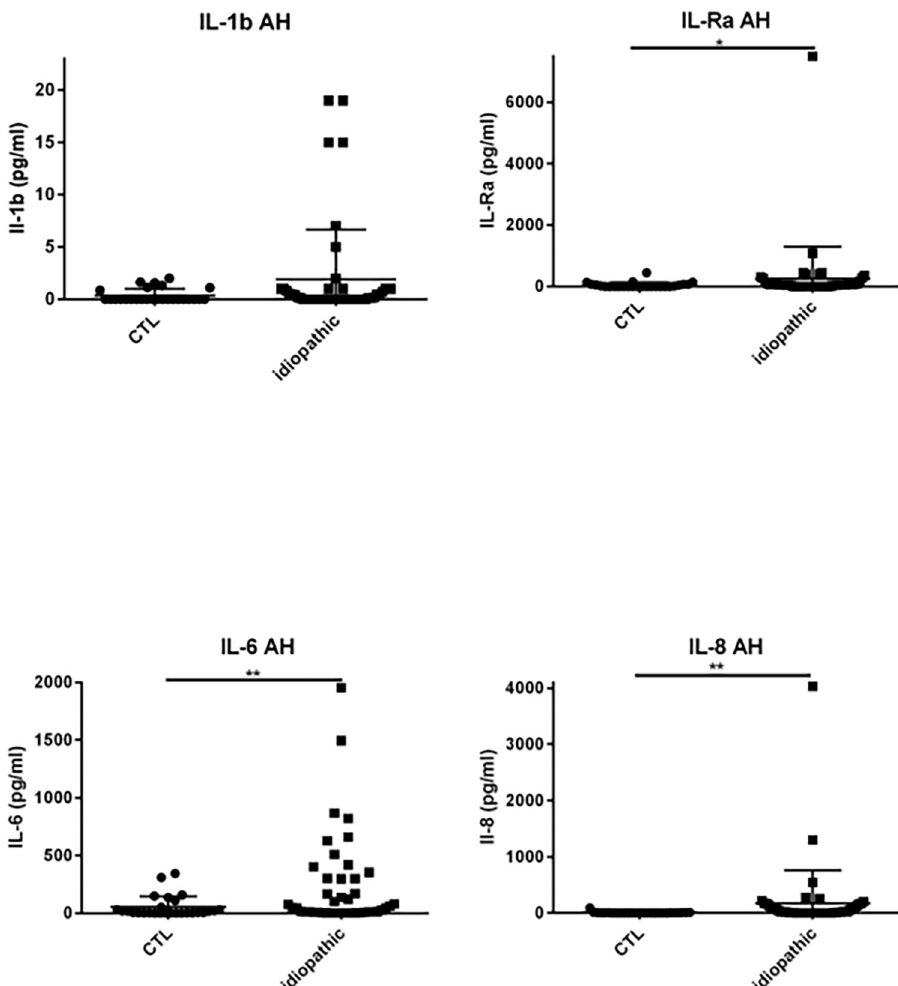
Fig 3. Dot plots of immune mediators: IL-1 β , IL1-R α , IL-6, IL-8, in aqueous humor of patients with idiopathic uveitis (N = 64) as compared with immune mediators in the aqueous humor of noninflammatory controls patients (cataract age-related) (N = 36). Note that few isolated patients with idiopathic uveitis had an immune mediator elevated. � = P < 0.05 ; �� = P < 0.01; ��� = P < 0.001.